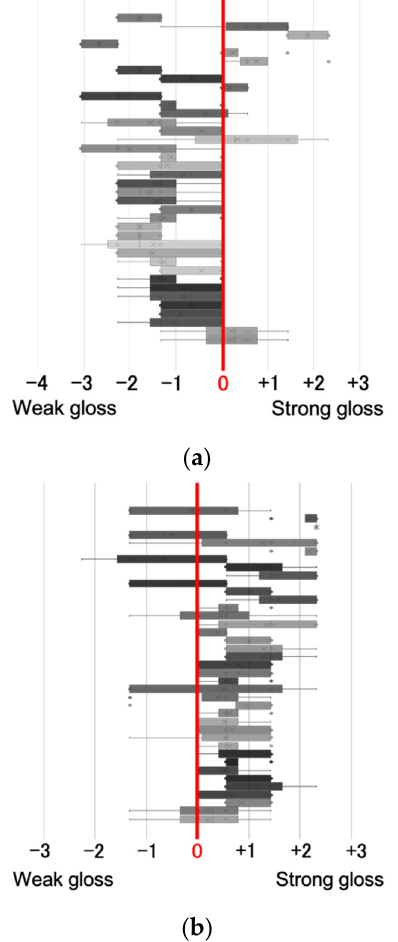
Figure 15. Results of Evaluation Experiment. ( a ) Xperia1; ( b ) FireHD8.